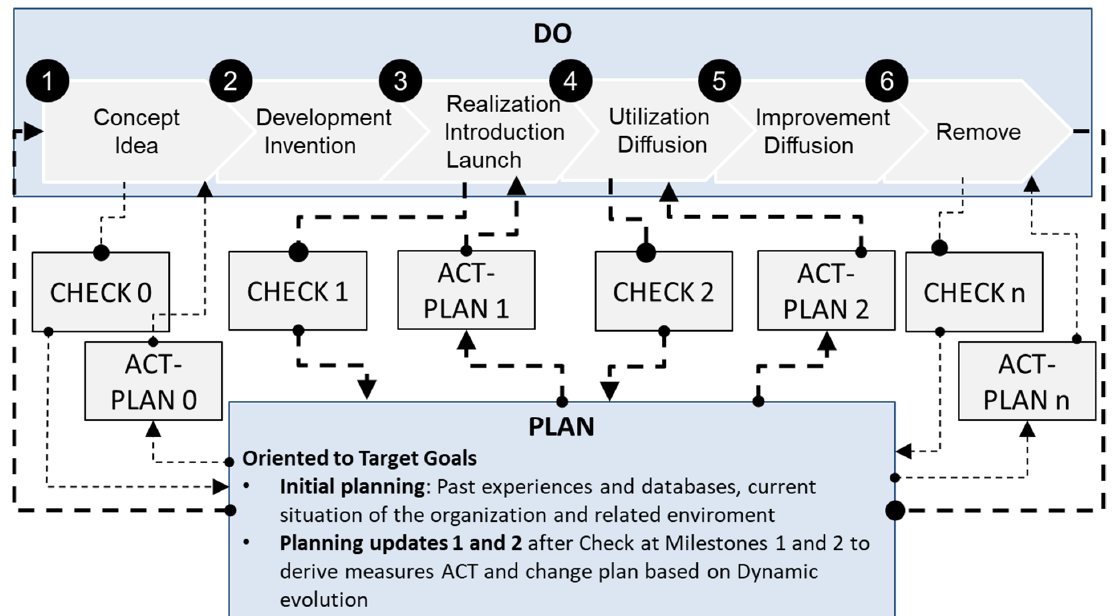
Figure 8. Innovation life cycle and project planning based on the PDCA methodology (own elaboration).